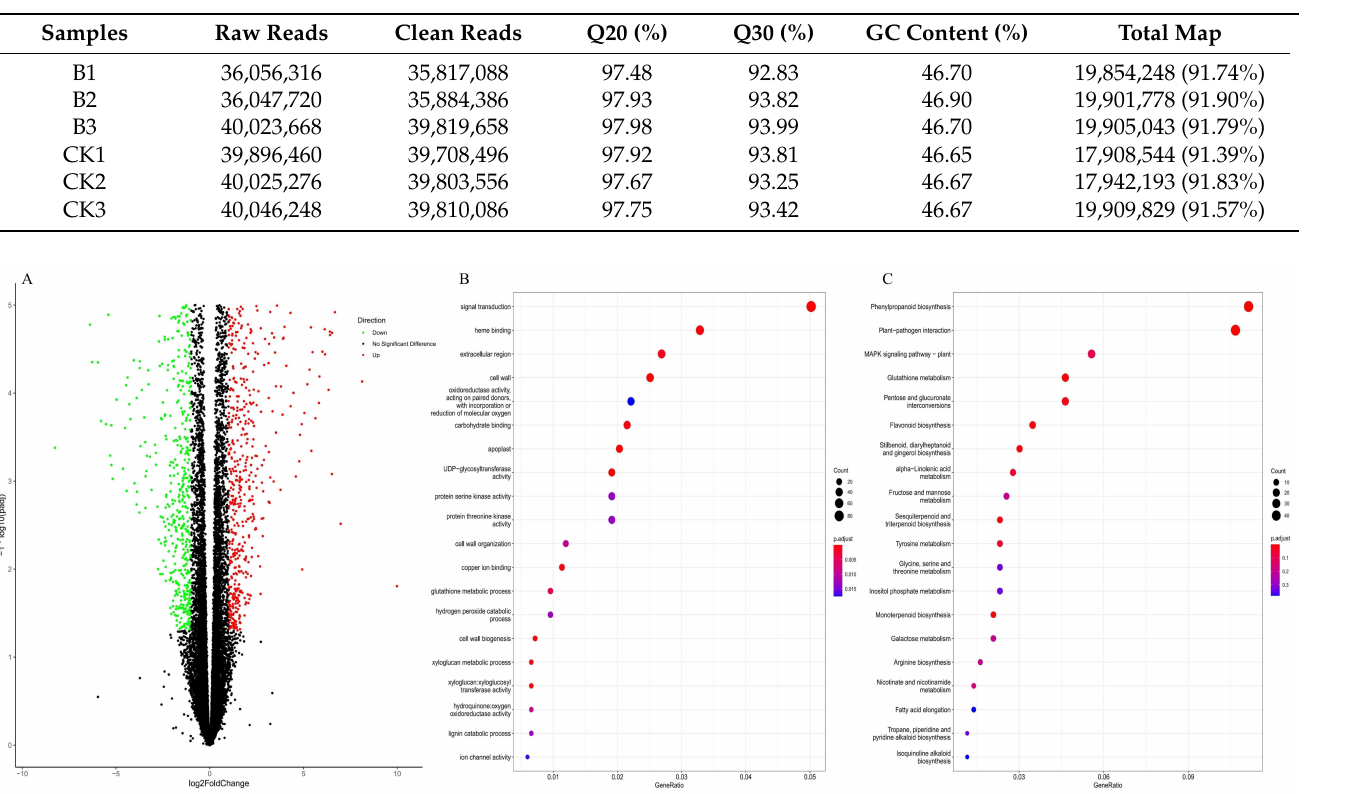
Figure 3. Transcriptome sequencing analysis of different expressed genes (DEGs) in P. betulaefolia root under 24 h B-deficiency treatment. ( A ) refer to volcano plot of DEGs; ( B , C ) refer to GO and KEGG